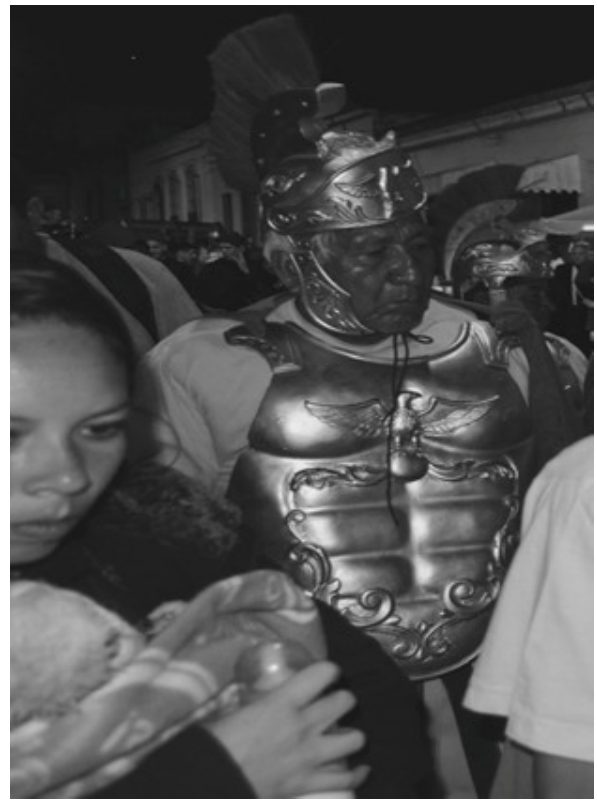
Figure 4. Roman Character during Palm Sunday, 2017. Photo: Karen Ponciano.